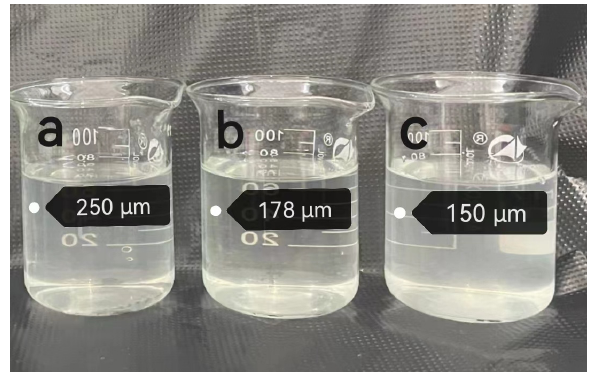
Figure 8. ( a ) 250 µ m CNMs suspension; ( b ) 178 µ m CNMs suspension; ( c ) 150 µ m CNMs suspension. Table 5. The viscosity of CNMs suspensions with different particle